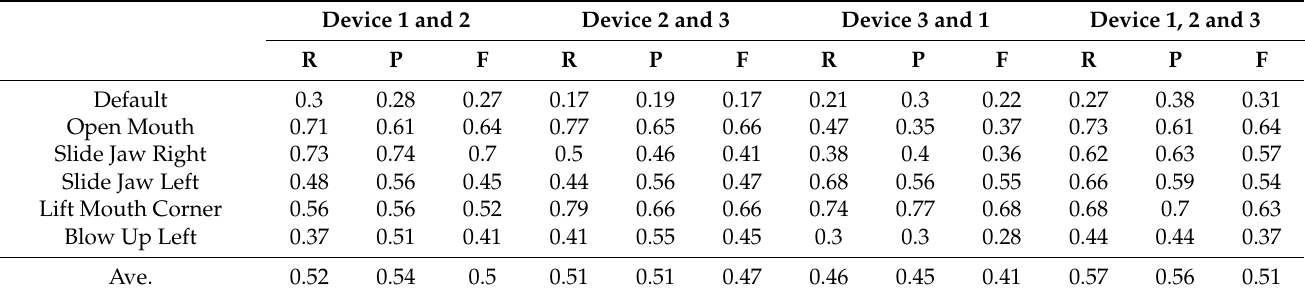
Table A6. The results of multiple device combinations for each gesture in Evaluation